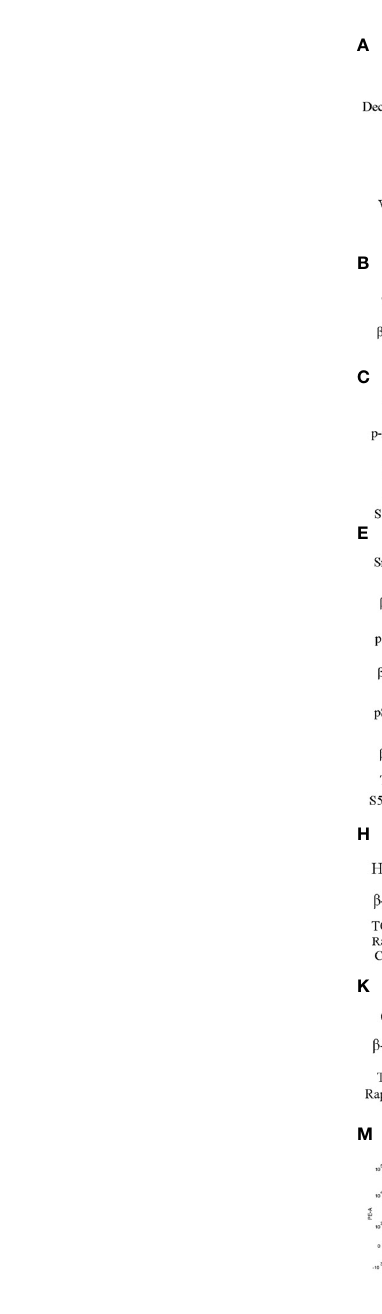
FIGURE 7 | TGF-b induces the expression of CD73 on HTR-8/SVneo cells via mTOR-HIF-1a. (A) Immunohistochemical staining and villous tissues from normal and URSA pregnancies. Results are shown as mean ± SEM, n = 3 (*P < 0.05, **P < 0.01, two-tailed t tests). (B) Western blot analysis of TGF- b in the villous tissues from normal and URSA pregnancies. Results are shown as mean ± SEM, n = 3 (**P < 0.01, two-tailed t tests). (C, D) Western blot analysis of mTOR and pmTOR in HTR- 8/SVneo cells cultured with or without rhTGF- b (10 ng/mL) and the Smad2/3 inhibitor S525334. (E, F) Western blot analysis of Smad2/3 and pSmad2 and pSmad3 in HTR-8/SVneo cells cultured with or without rhTGF- b (10 ng/mL) and the Smad2/3 inhibitor S525334. (G) Relative mRNA levels of HIF-1 a in the HTR-8/SVneo cells cultured with or without CoCl 2 (100 mM). (H, I) HTR-8/SVneo cells were treated with or without rapamycin (10 nM) for 1 hour, and then stimulated with rhTGF- b (10 ng/mL) (or vehicle) and CoCl 2 (100 mM) for 12 hours. The whole cell lysate was analyzed for HIF-1 a by Western blot. (J) HTR-8/SVneo cells were cultured with or without CoCl 2 (100 mM) and the HIF-1 a inhibitor MeoE2 (10 mM) for 24 hours. Relative mRNA levels of CD73 were measured by RT-PCR. (K, L) HTR-8/SVneo cells were treated with the mTOR inhibitor rapamycin (10 nM) for 1 hour and then with rhTGF- b (10 ng/mL) or vehicle for 24 hours. The whole cell lysate was analyzed for CD73 by Western blot. (M, N) The percentages of CD73 + HTR-8/SVneo cells from the abovementioned experiment were further analyzed with fl ow cytometry. Means of three different experiments ± SEM are shown (*P < 0.05, **P < 0.01, ***P < 0.001, ****P < 0.0001, two-tailed t tests or one-way ANOVA and post hoc